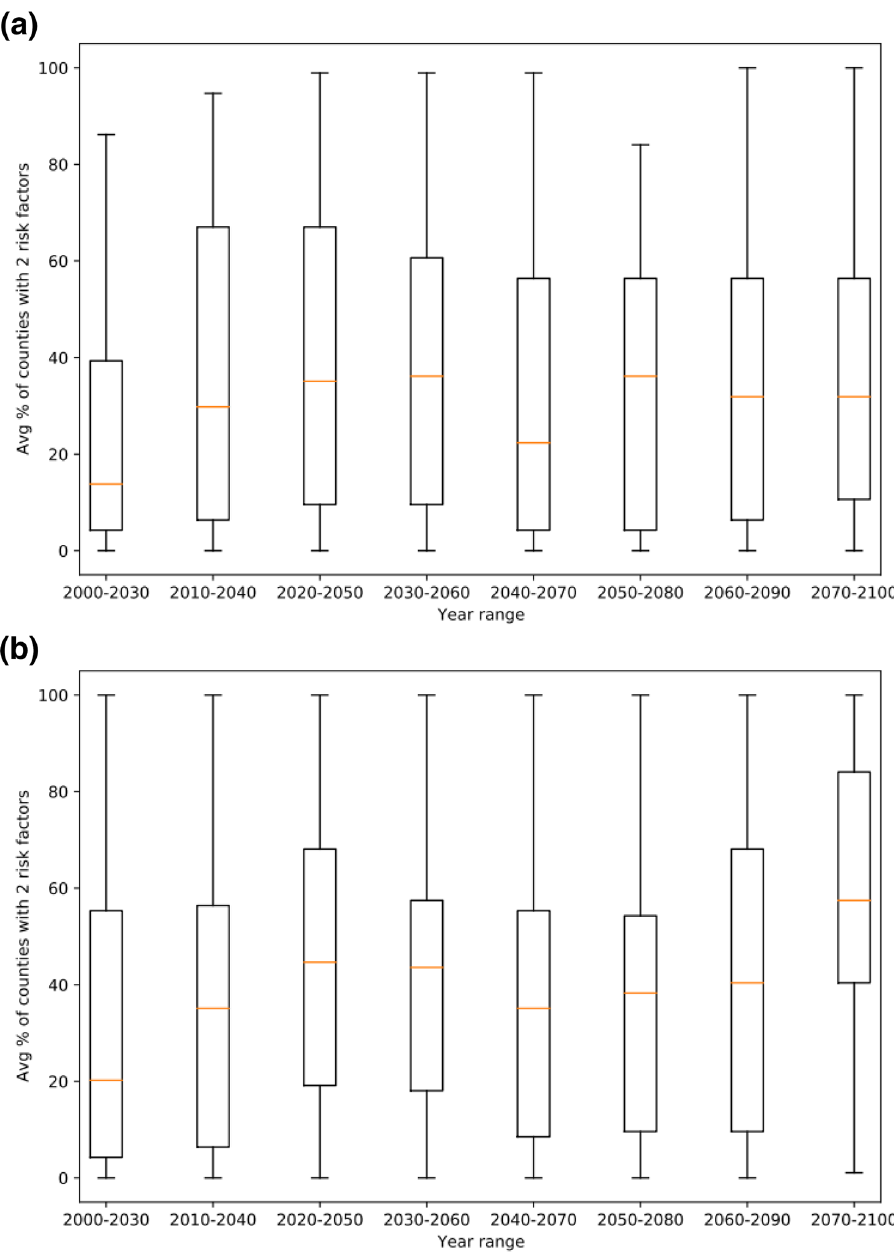
Figure 2. Average percentage (%) of counties in southern Georgia, USA predicted to exceed two weather risk factor thresholds for 30 years periods under the (a) RCP 4.5 scenario and (b) RCP 8.5